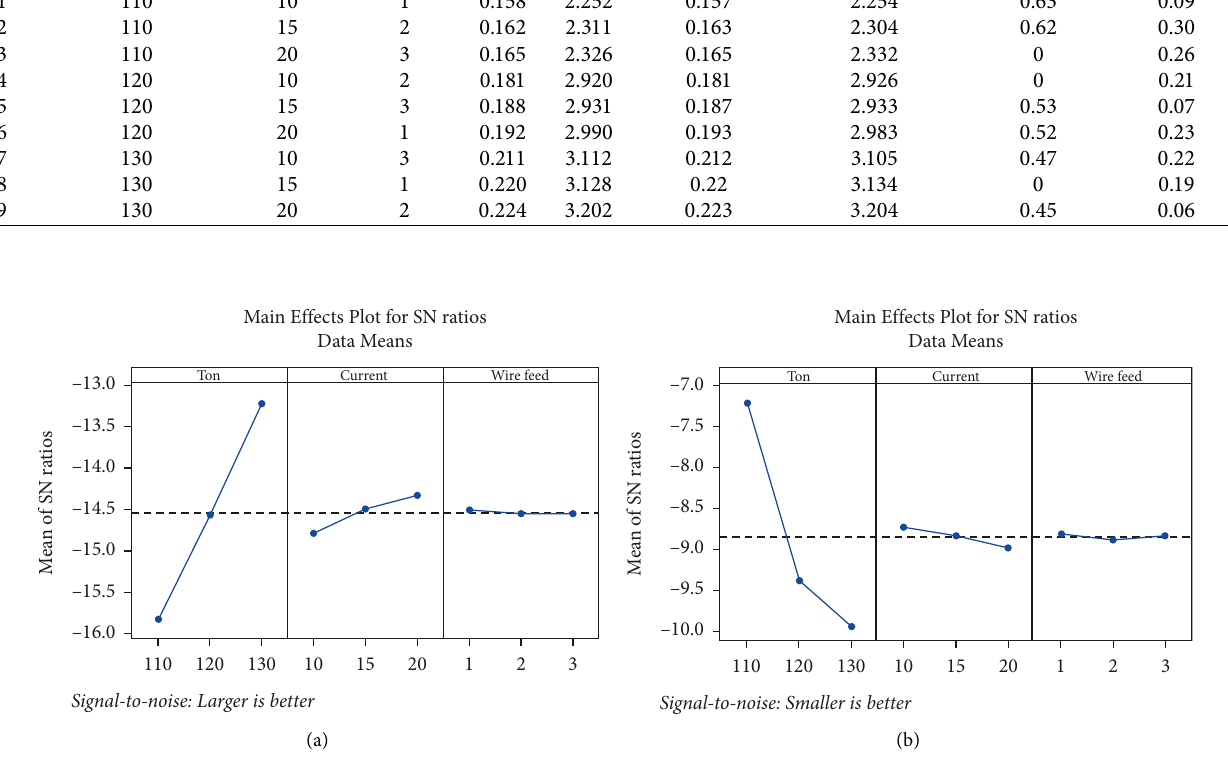
Figure 2: Mean effect plots for MRR and R